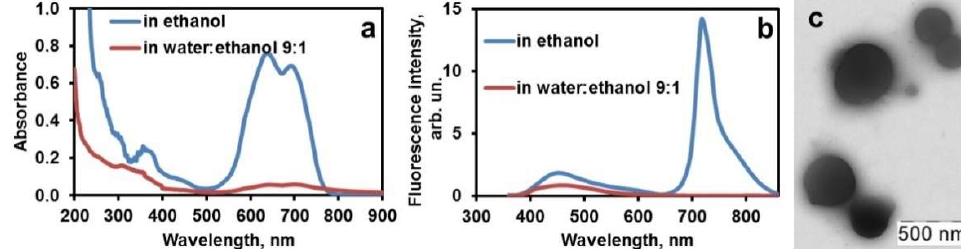
Figure 1. Absorbance ( a ) and fluorescence ( b ) spectra of ethanolic and aqueous solutions of 1 μM dye; ( с ) TEM image of dye particles in water.